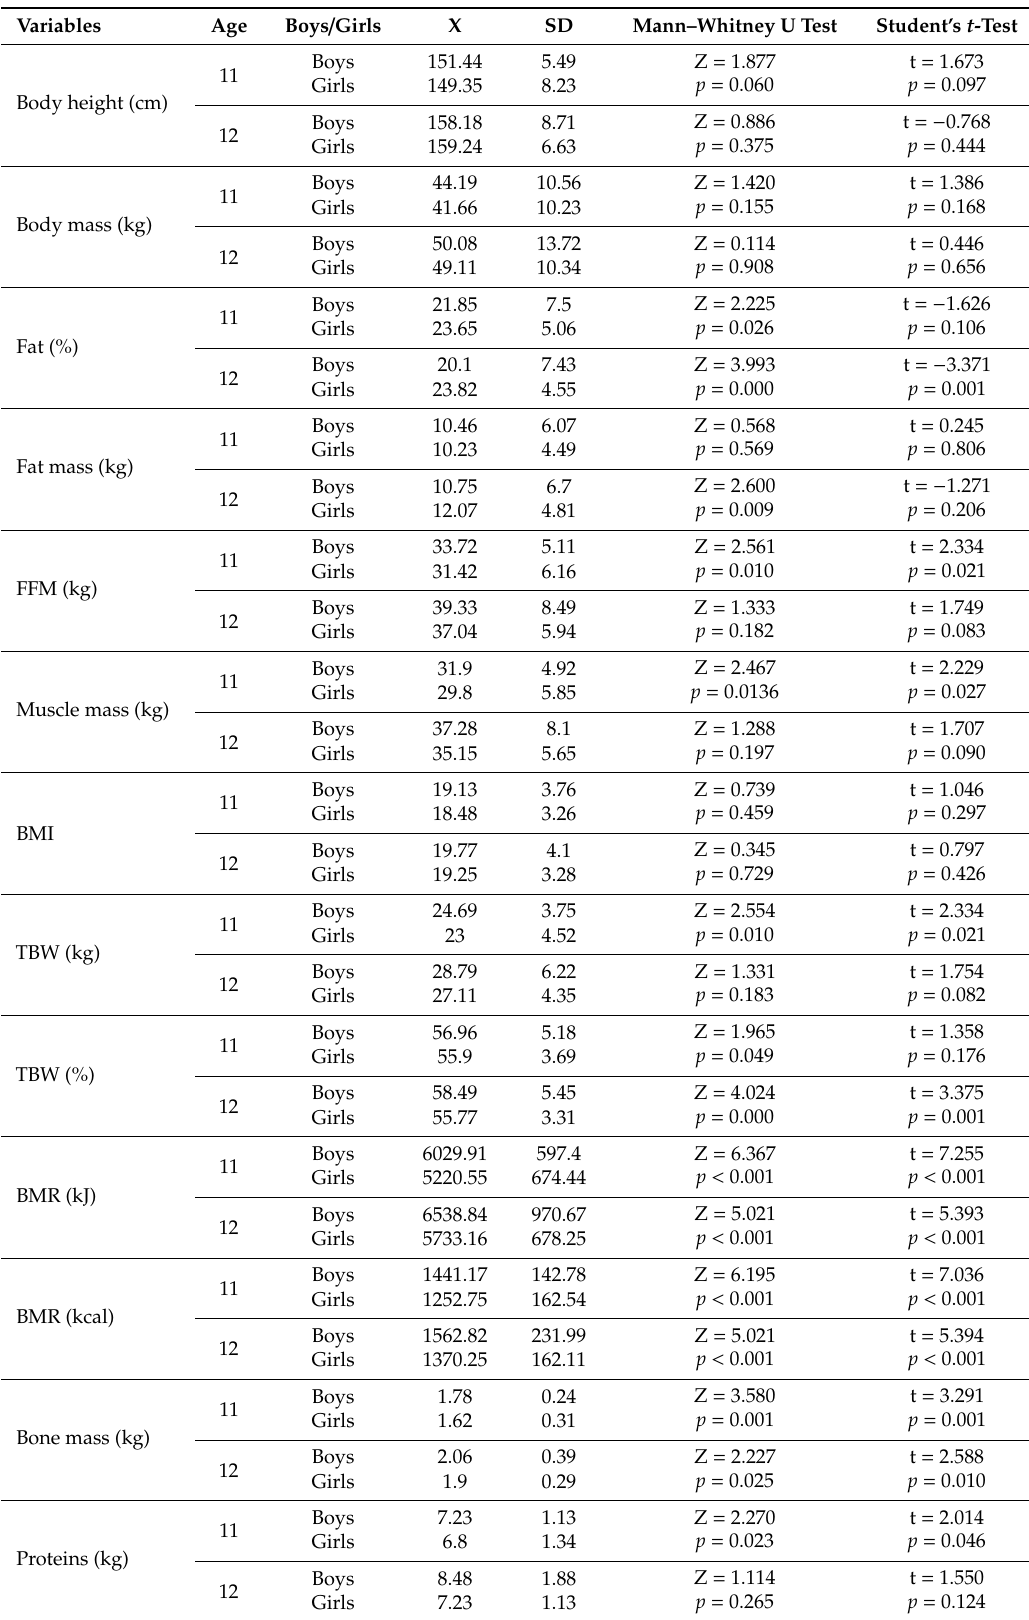
Table 1. Results of analysed variables according to